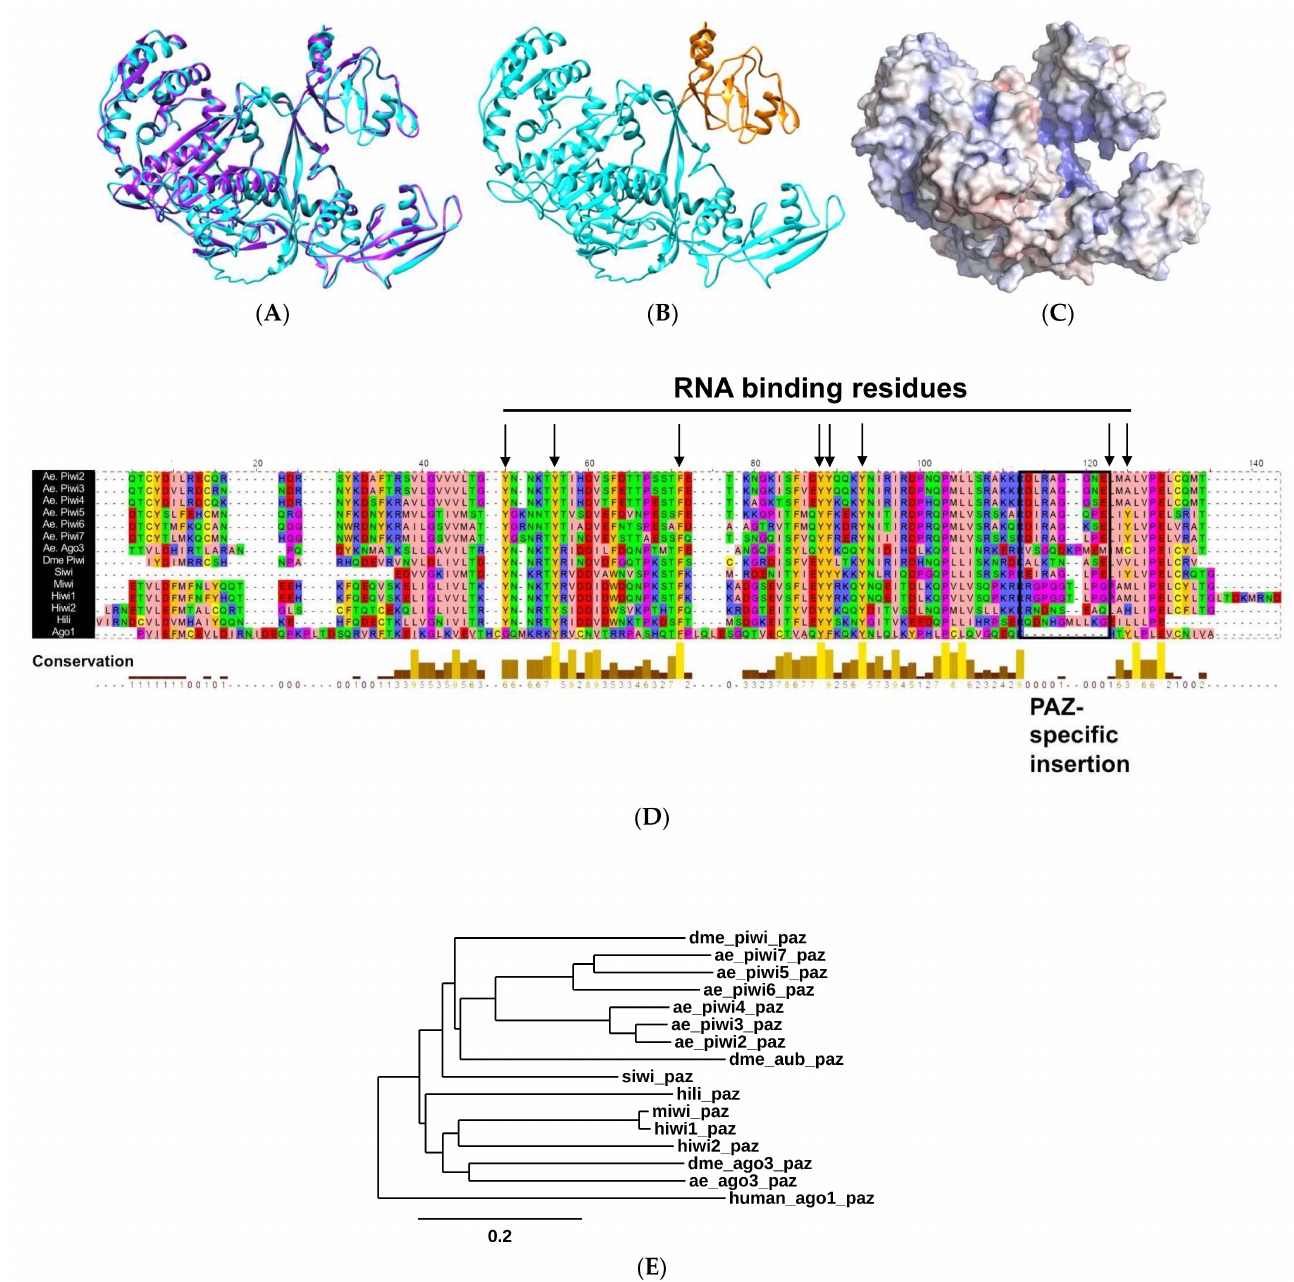
Figure 1. Predicted A. aegypti Piwi4 RNA-binding properties. ( A ) Predicted A. aegypti Piwi4 model (blue) superimposed with the crystalized Drosophila Piwi structure (purple); ( B ) predicted A. aegypti Piwi4 structure (blue) with PAZ domain highlighted in orange; ( C ) electrostatic density of A. aegypti Piwi4 where red = negatively charged and blue = positively charged. Structure is rotated on the right to reveal inner positively charged pocket; ( D ) alignment of Piwi PAZ domains, including all A. aegypti Piwis (Ae. Piwi2-7 and Ae. Ago3) and crystalized or characterized Piwi PAZ ( Drosophila (Dme) Piwi, silkworm Piwi (Siwi), mouse Piwi (Miwi), and human Piwis Hiwi1, Hiwi2, and Hili). The human Argonaute protein Ago1 was also included as an outgroup. Black arrows indicate known RNA-binding residues by crystal structures, which in this alignment include amino acid numbers 50, 56, 71, 88, 89, 93, 123, and 125. Black box indicates the Piwi PAZ- specific insertion site. Colors (Zappo color scheme) indicate biochemical properties where peach = aliphatic/hydrophobic, aromatic = orange, blue = positively charged, red = negatively charged, green = hydrophilic, pink = conformationally special, and yellow = cysteine; ( E ) phylogenetic tree of all Piwi PAZ included in the alignment shown in 1D, with the addition of Drosophila Aubergine and Ago3 PAZs. Scale bar indicates number of substitutions per